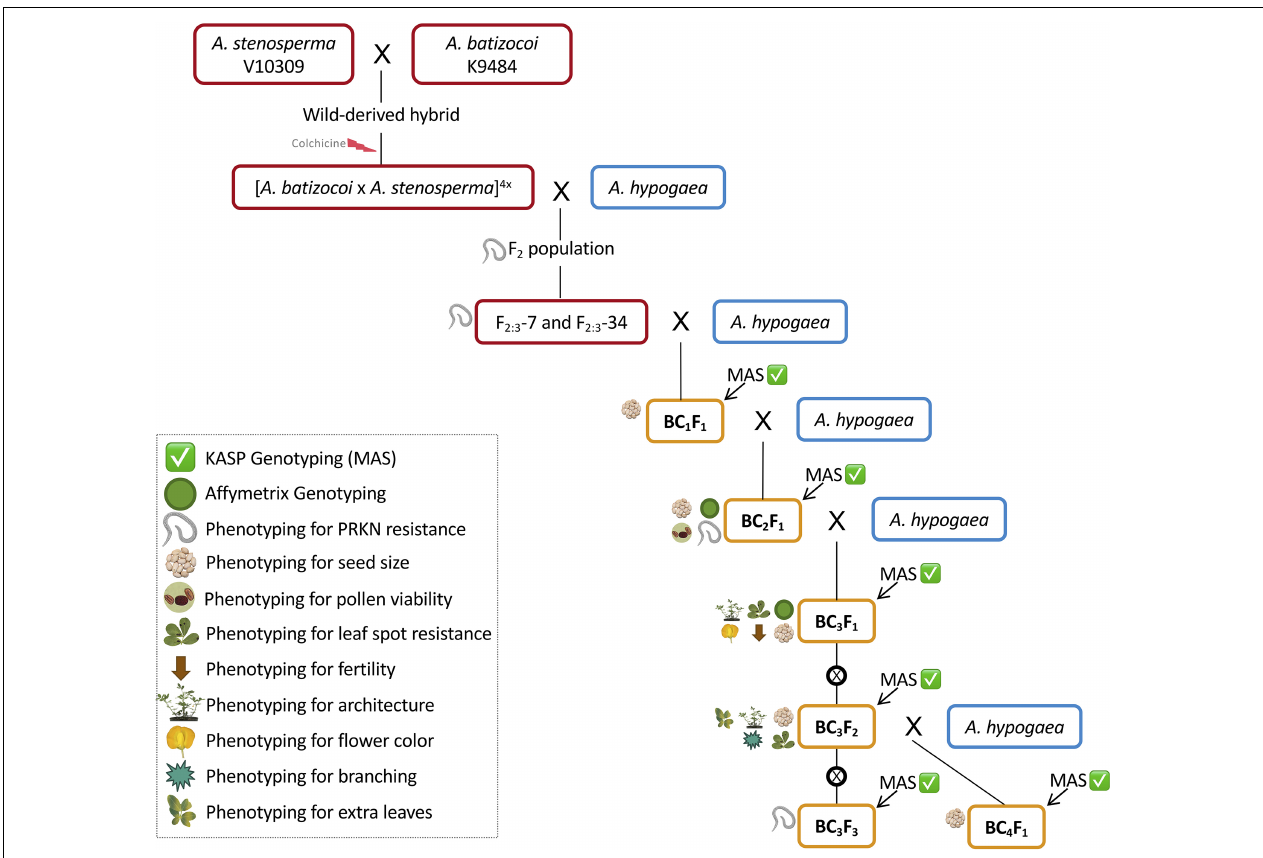
FIGURE 1 | Schematic of the marker-assisted backcrossing scheme for incorporation of peanut root-knot nematode resistance from the wild species A. stenosperma V10309 into peanut breeding lines from Tifton, GA. Superior F 2 -derived F 3 lines (Ballén-Taborda et al., 2019) were selected as donor parents (DP, red boxes). Recurrent parents (RP, blue boxes) included TifGP-2, 5-646-10, 13-1014, 13-2113, and 13-1125. In each cycle, KASP genotyping was performed to identify lines carrying resistance loci in chromosomes A02 and A09 (Marker-assisted selection – MAS) (green checkmark) ( Supplementary Tables 1 , 2 , gray-shaded markers). BC n F n progeny from each cycle were used as male parents for the next (orange boxes). All BC n F n s were genotyped for seed size (weight, length, and width) (seed symbol). BC 2 F 1 s were genome-wide genotyped and phenotyped for PRKN resistance for validation (green circle and nematode symbol) (Ballén-Taborda et al., 2021) and pollen viability was studied (pollen symbol). BC 3 F 1 s were subjected to genome-wide genotyping for characterization of introgressions (green circle) and phenotyped for leaf spot incidence, fertility, architecture, and flower color (indicated by leaf spot, brown arrow, architecture, and flower symbols, respectively). BC 3 F 2 s were phenotyped for leaf spot incidence, architecture, branching, and extra leaves (indicated by leaf spots, architecture, branching, and leaves symbols, respectively).